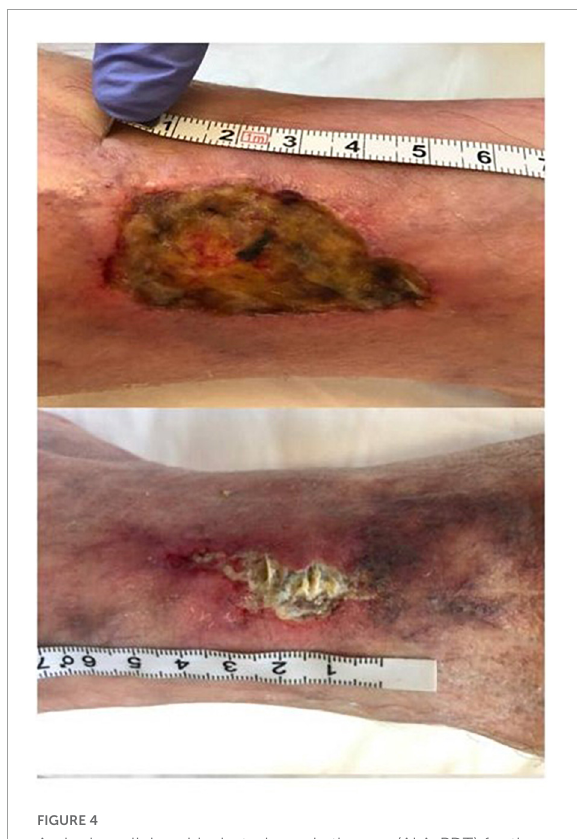
FIGURE4 Aminolaevulinic acid-photodynamic therapy (ALA-PDT) for the infected leg ulcer. A patient with chronic foot ulcer before and after 3 cycles of PDT (figure adapted from the reference 107 with no change).